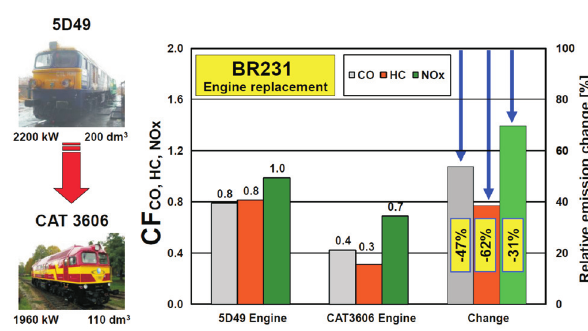
Fig. 16. Replacement of worn out locomotive engines with new designs